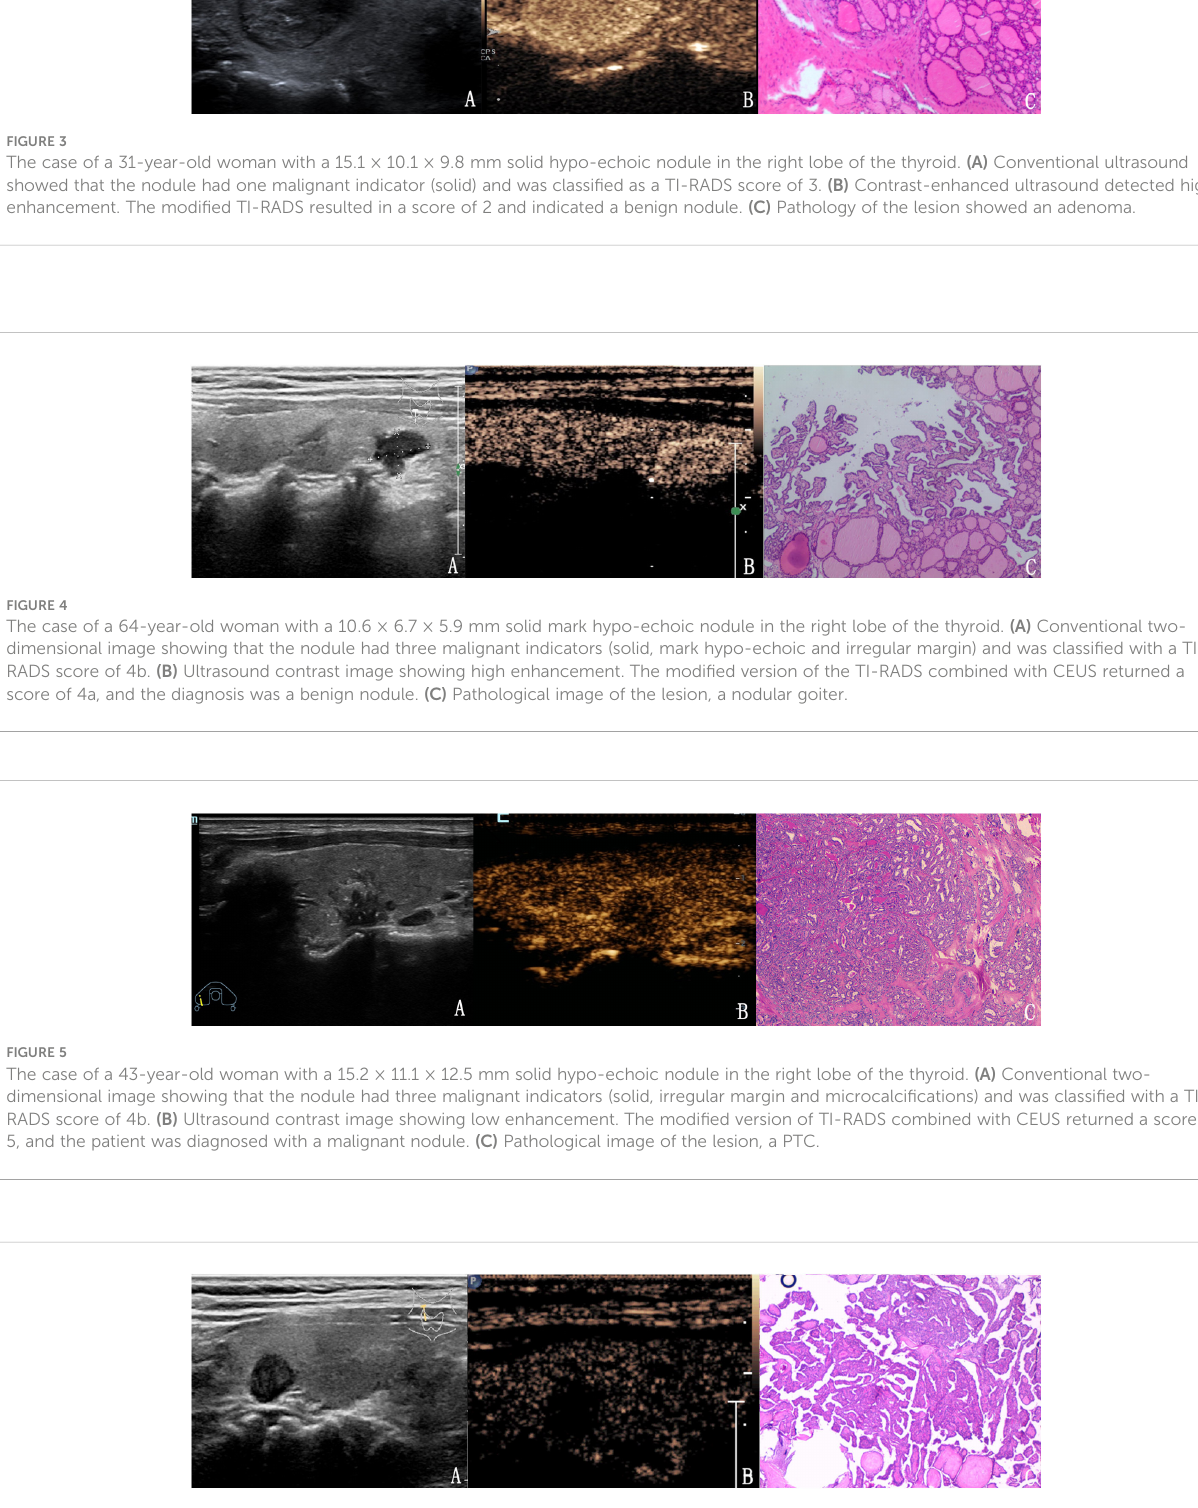
FIGURE 6 The case of a 47-year-old man with a 7.8 × 6.8 × 7.5 mm solid mark hypo-echoic nodule in the right lobe of the thyroid. (A) Conventional two- dimensional image showing that the nodule had two malignant indicators (solid, mark hypoechoic) and was classi fi ed with a TI-RADS score of 4a. (B) Ultrasound contrast image showing low enhancement. The modi fi ed version of the TI-RADS combined with CEUS returned a score of 4b and the diagnosis was a malignant nodule. (C) Pathological image of the lesion, a PTC.